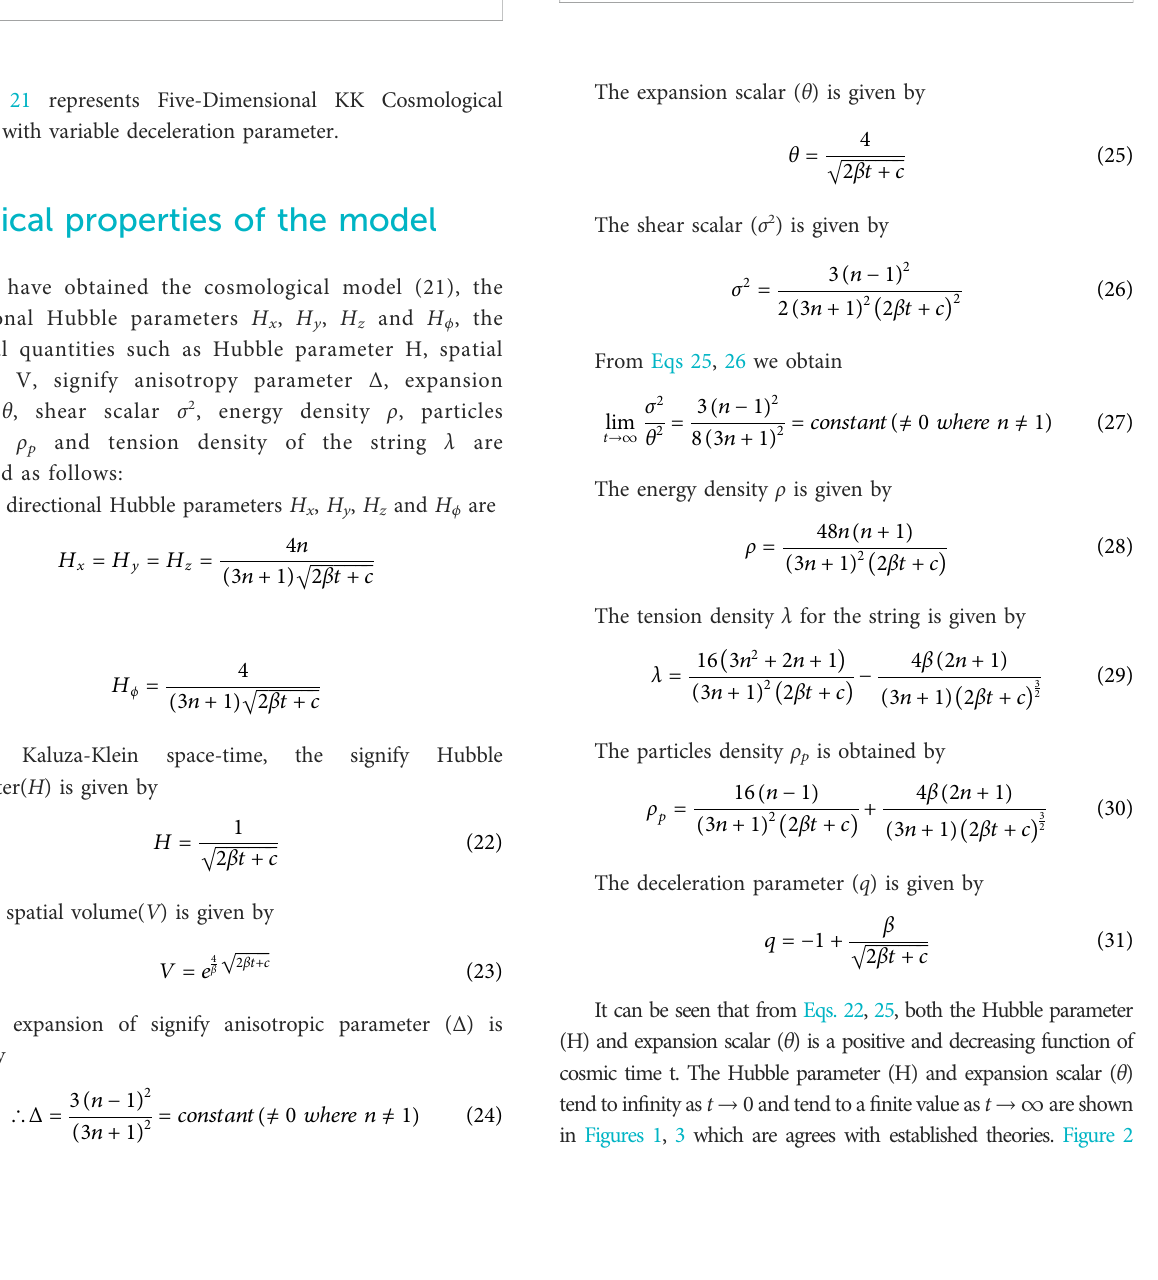
FIGURE 1 The plot of Hubble parameter H versus time t.